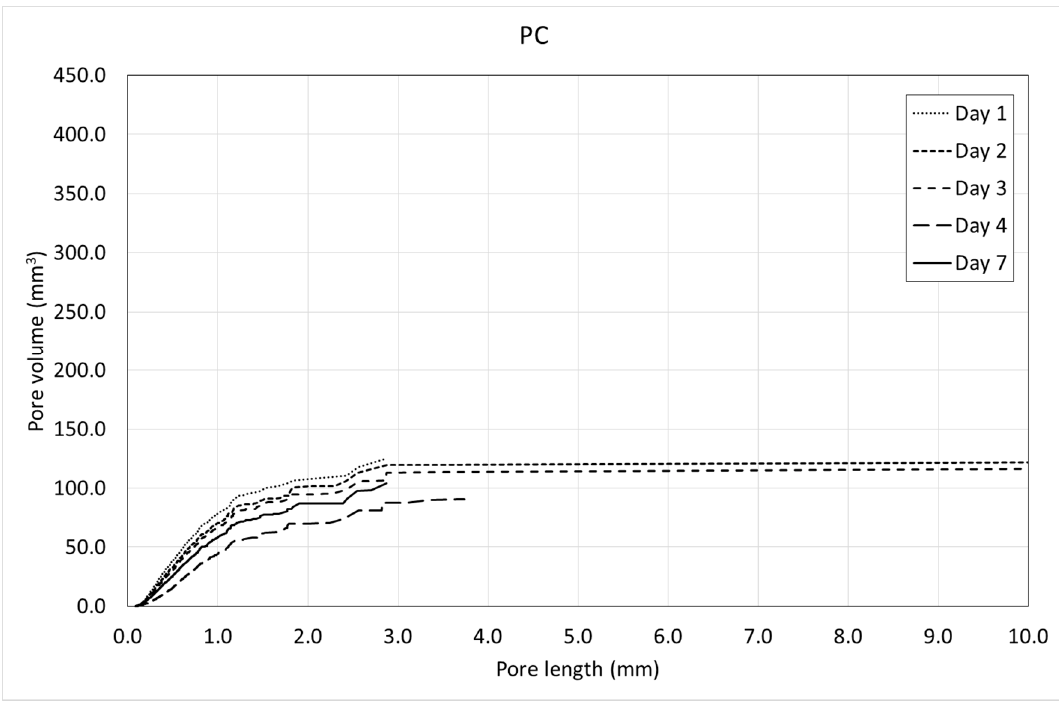
Figure 14. Pore volume curves of PC.